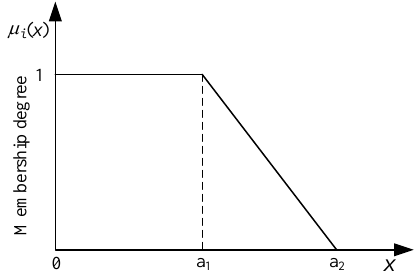
Figure 8. Membership function of the trapezoidal fuzzy